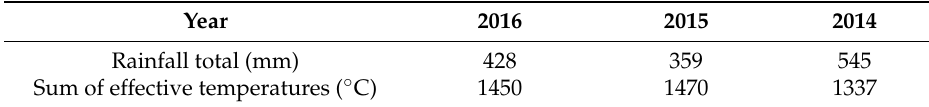
Table 2. Wine Area: Znojmo—Oblekovice (sampling site